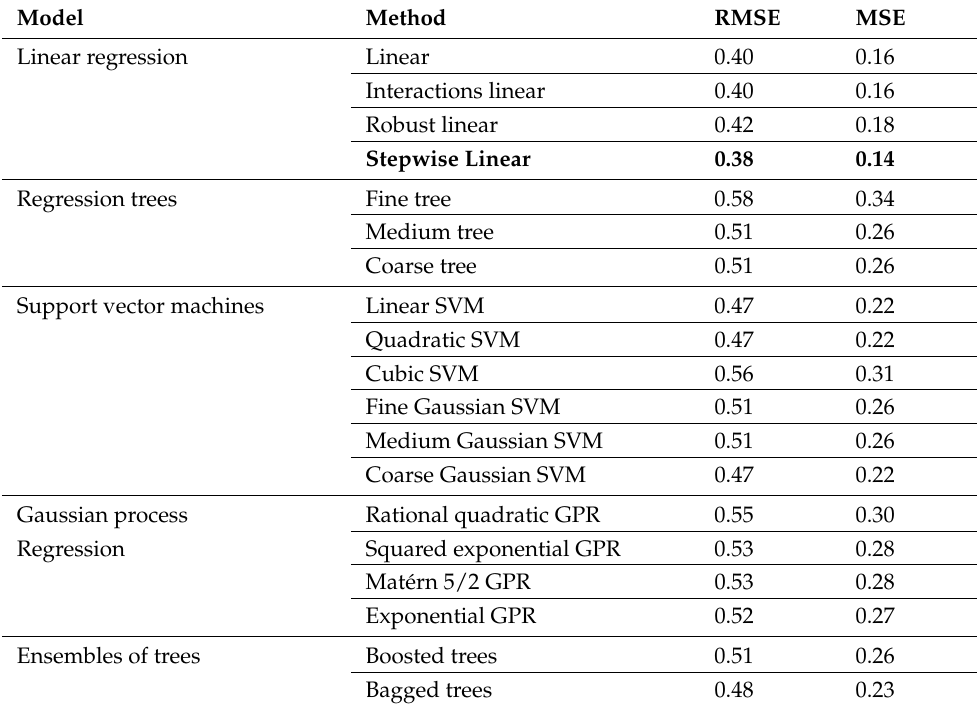
Table 5. Tested algorithms and corresponding RMSE/MSE. Stepwise linear has the best RMSE/MSE.